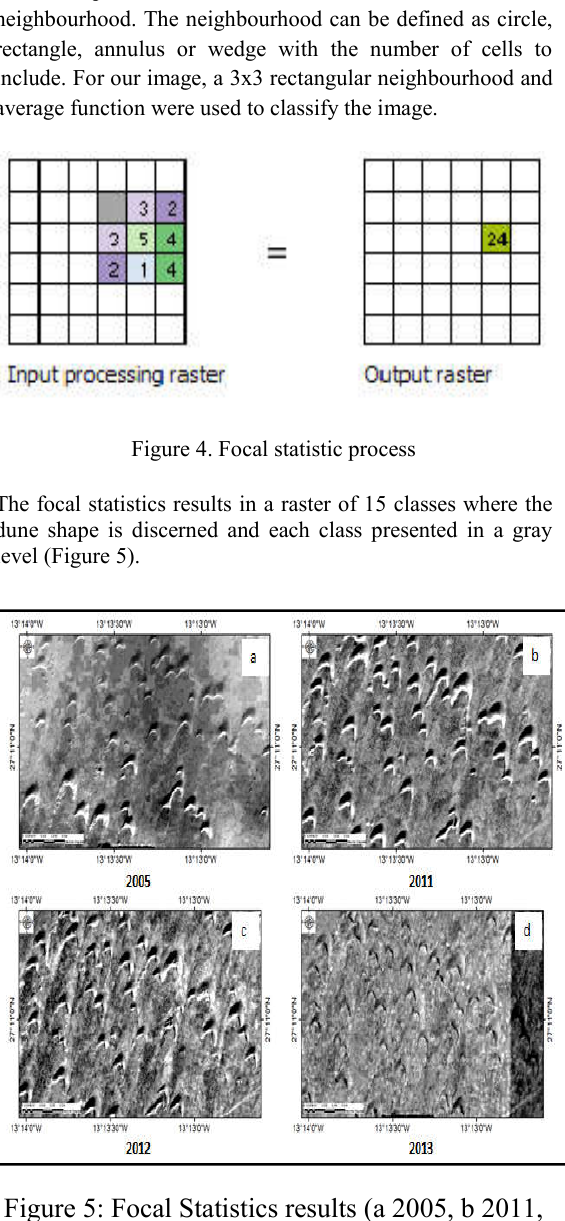
Figure 5: Focal Statistics results (a 2005, b 2011, c 2012, d 2013)